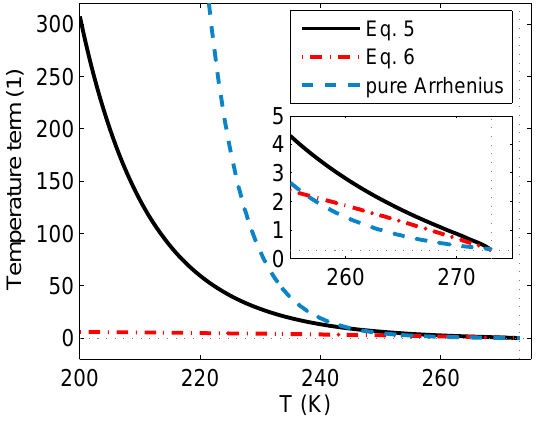
Fig. 3. Temperature term of the viscosity according to the current formulation (Eq. 5), the previous parameterization (Eq. 6) and a pure Arrhenius term as described in Sect. 3.3. The new temperature dependence of viscosity results in stiffer snow at low temperatures while nearing the melting point a more pronounced temperature de- pendence than both the other parameterizations is achieved (see in- sert). Table 1. Description of the terms ( Q i ) in Eq. (7). The coefficient values correspond to the standard SNOWPACK implementation (re- lease